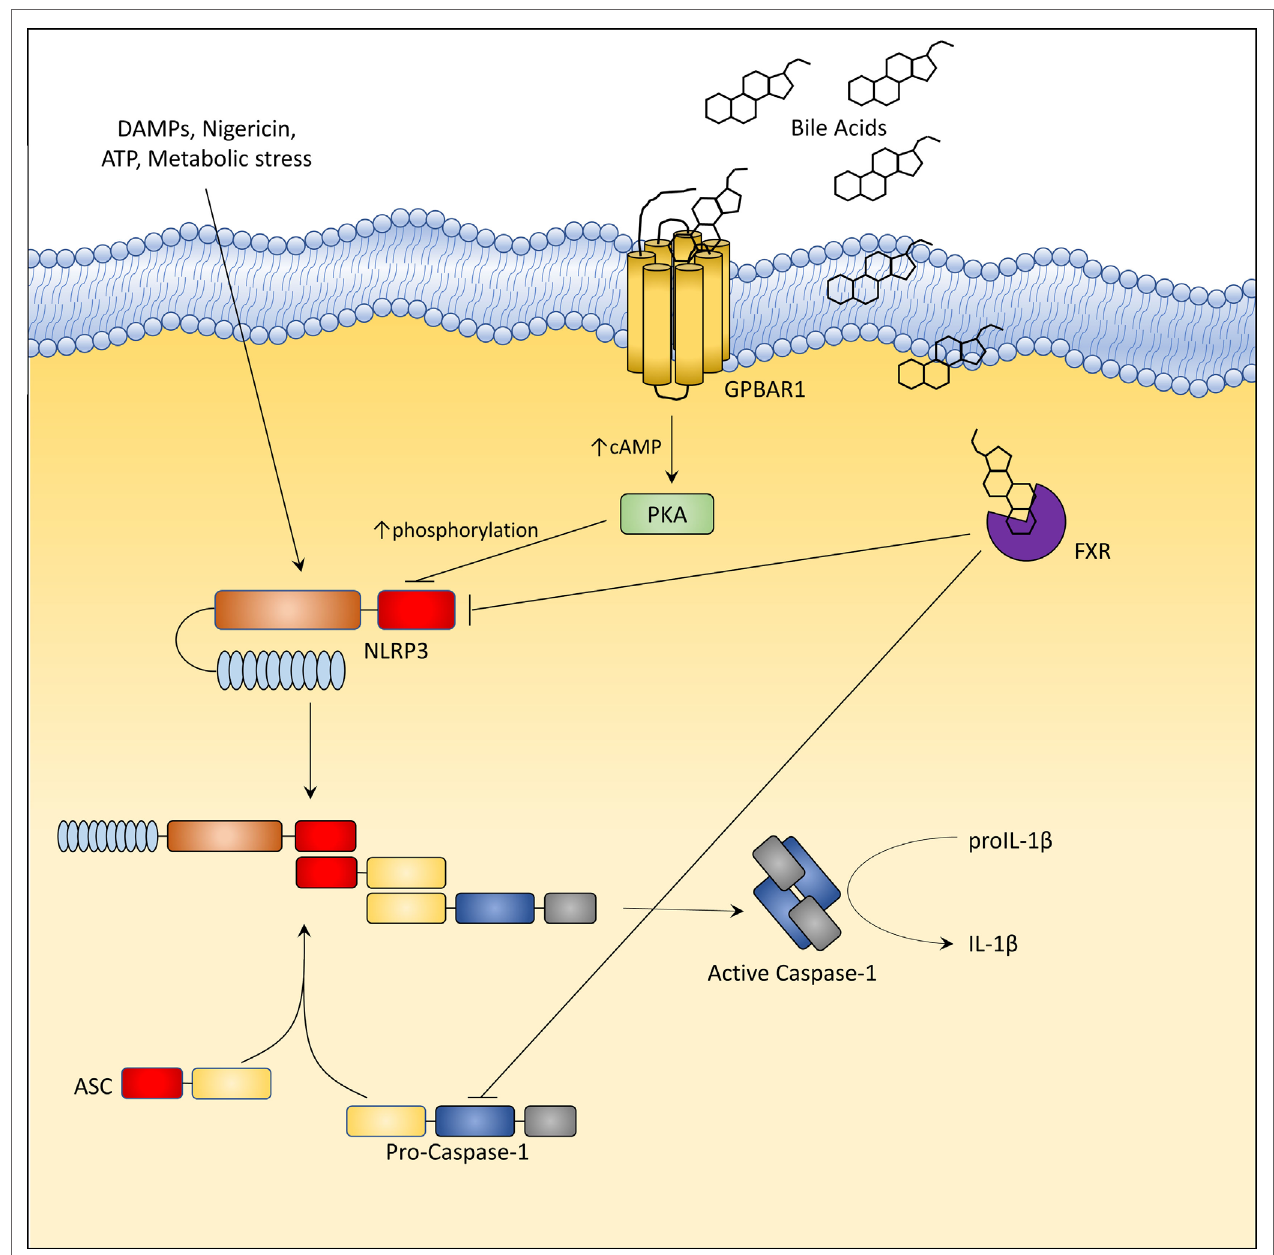
FiGuRe 4 | G-protein bile acid receptor 1 (GPBAR1) and Farnesoid-X-Receptor (FXR) activation inhibit the activation of NLRP3 inflammasome. In liver macrophages, GPBAR1 ligation lead to a protein kinase A (PKA)-dependent phosphorylation of NLRP3 at Ser291 (Ser295 in humans). This phosphorylation, induced by PKA kinase activation, promotes NLRP3 ubiquitination thus preventing the assembly of NLRP3 inflammasome. PKA-induced phosphorylation of NLRP3 served as a critical brake on NLRP3 inflammasome activation. Instead, FXR-mediated inhibition of the NLPR3 inflammasome appears to be mediated by the physical interaction of FXR with NLRP3 and caspase 1, thus preventing their assembly into inflammasome. However, in cholestasis, a disorder characterized by impaired secretion of bile and high levels of circulating bile acids (up to 500 µM), bile acids might activate NLRP3 inflammasome acting as DAMPs or through GPBAR1-dependent activation of the GPBAR1/EGFR-ERK/AKT/JNK